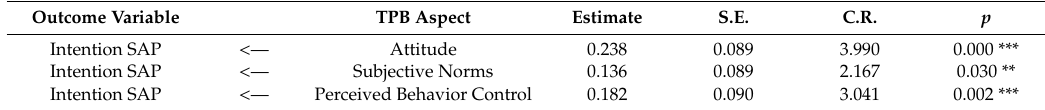
Table 7. SEM estimation.